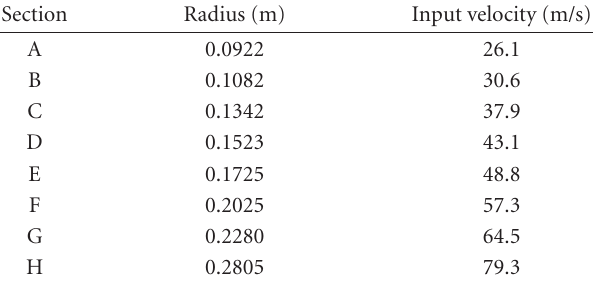
Table 2: Input velocity for two-dimensional